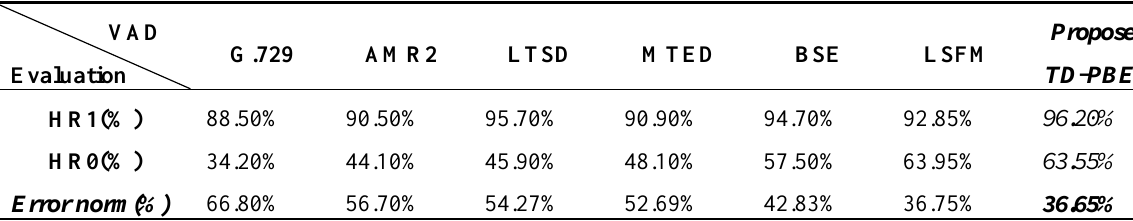
Table 4. Average speech/non-speech hit rates and overall false error norm for SNR level from clean to −5